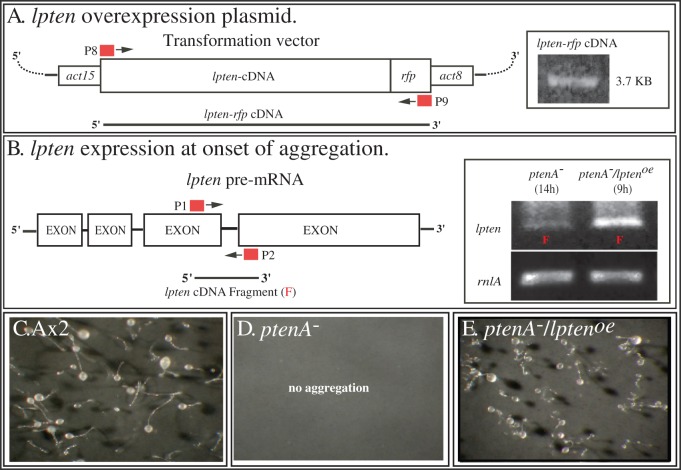
Overexpressing lpten− in the ptenA− mutant.A. The transformation vector used to generate strains ptenA−/lptenoe, in which lpten is under the regulation of the actin 15 (act15) promoter, fused in frame at the 3′ end to the red fluorescent protein gene (rfp) and terminating with a 3′ actin 8 gene sequence. The positions of the primers P8 and P9, for generating the lpten-rfp cDNA, are denoted. Insert shows verification of the lpten-rfp cDNA by PCR. B. lpten is expressed in ptenA−/lptenoe cells at levels more than 10 times that in the parent ptenA− mutant. The positions of the primers (P1, P2) for RT-PCR of the 300 bp lpten fragment (F) are denoted. In the insert to the right of panel B, RT-PCR products of chemotactically responsive ptenA− and ptenA−/lptenoe cells reveals overexpression of lpten in the latter. Densitometry measurements revealed>10 fold overexpression. C. Fruiting body formation in Ax2 cultures. D. The absence of fruiting body formation in ptenA− cultures. E. Fruiting body formation in ptenA−/lptenoe cultures. See Table S1 for description of primers.